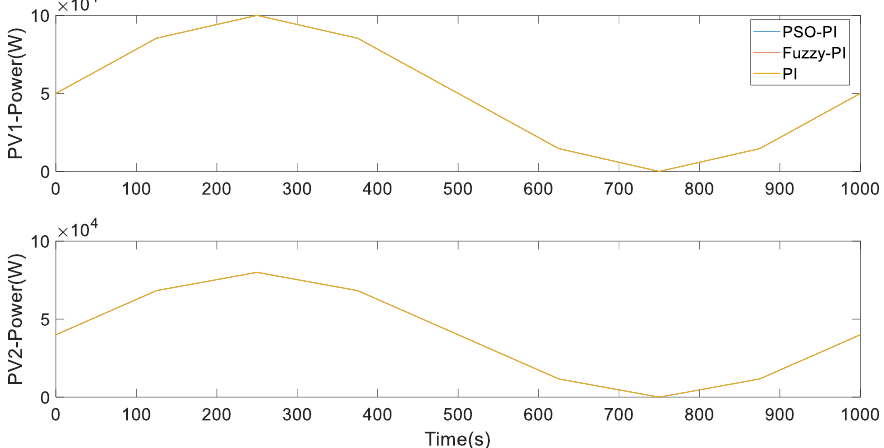
Figure 22. Output power of photovoltaic power generation unit in Example 2.